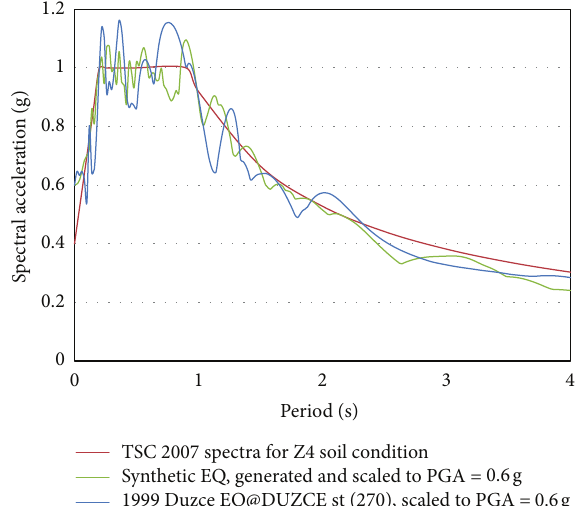
Figure 10: Absolute acceleration response spectra for Z4 soil condition according to TSC 2007 and two different earthquakes spectral accelerations on soft soil conditions.